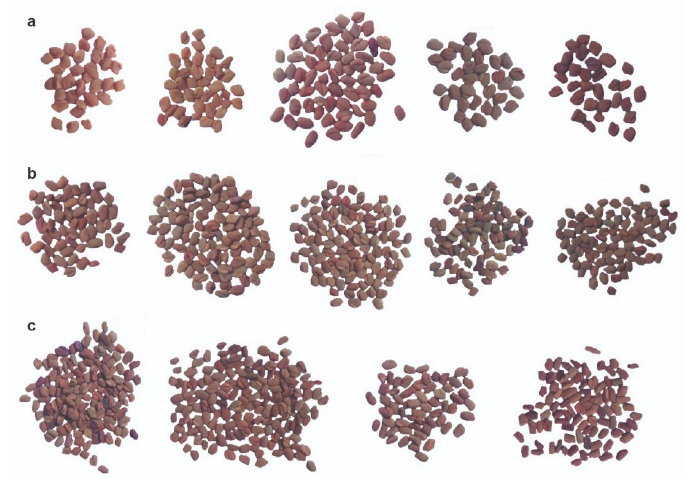
Figure 3. Images of the observed variation in seed length, width and color. Raw ( a ) include large seed size, raw ( b ) include medium seed size, and raw ( c ) include small seed size, all ascending from left to right based on color darkness.